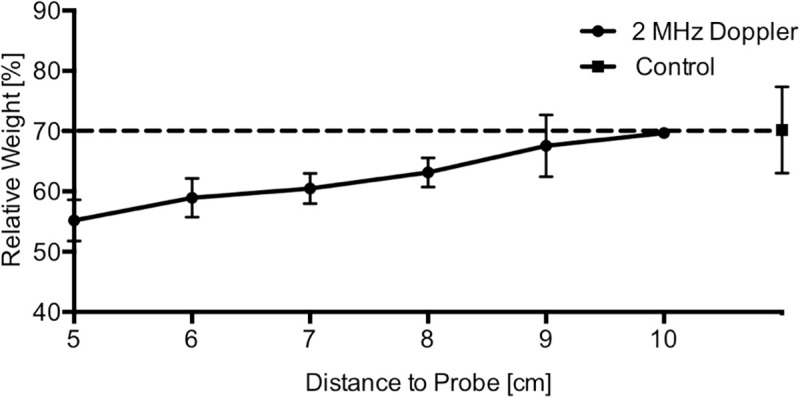
Lysis radius.The round dots symbolize the mean with standard deviation of relative clot weight (y-axis) after insonation with different distances to probe (x-axis). The square shows the mean and standard deviation of the control group 70.2±7.2%, which is defined as lysis threshold, shown as a dotted line.